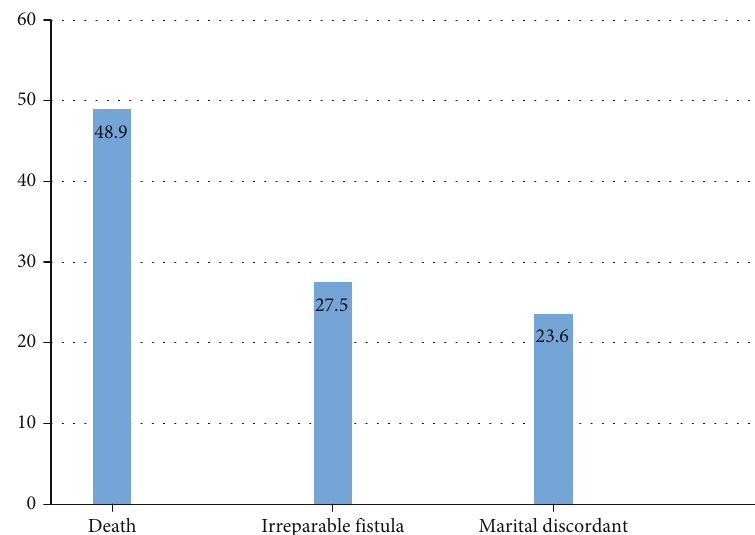
Figure 1: Percentage of fi stula survivors ’ ( n = 182 ) great concerns (fears) before the repair of their obstetric fi stula, central Gondar districts, Northwest Ethiopia, 2020.